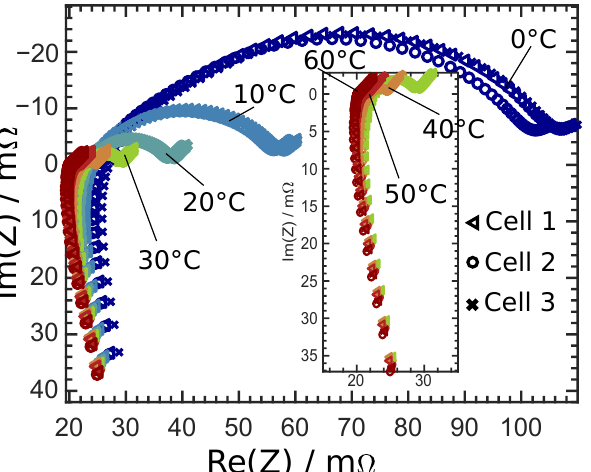
Figure 1. Nyquist plot for 3 Samsung INR18650-15L1 cells at different temperatures from 0 to 60 ◦ C. The impedance can also be detected in other battery states, such as the state of health with respect to nominal capacity ( C / C N , SoHC) and the state of charge (SoC); therefore, those other states can be crucial input variables for battery management systems